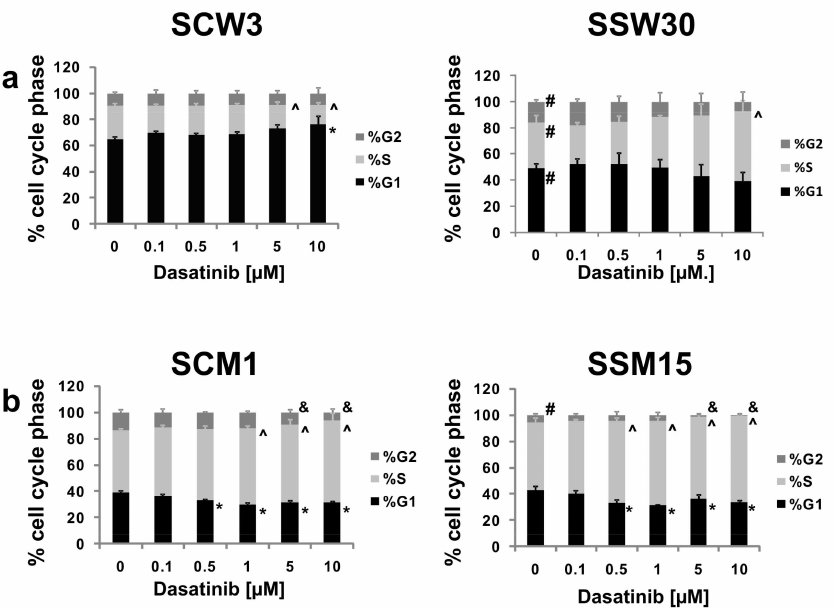
Figure 4. ( a ) Cell cycle phase distribution in SCW3 and SSW30 clones. ( b ) Cell cycle phase